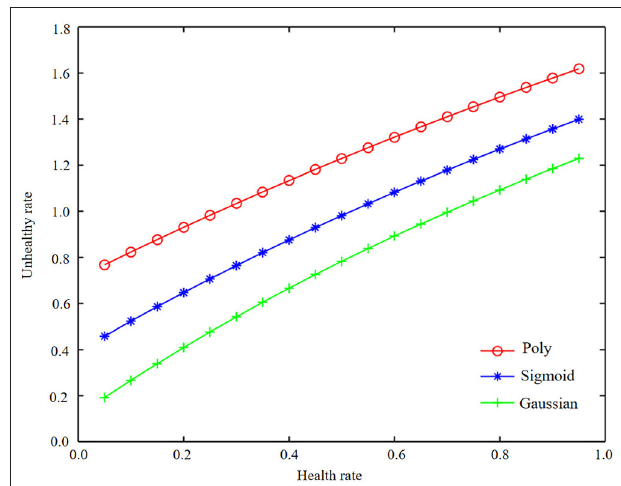
FIGURE 8 | The ROC curve representation of three kernel functions under machine learning combined data.